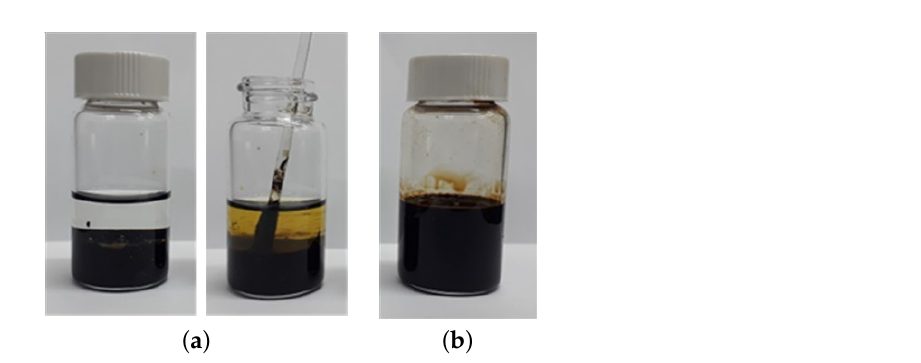
Figure 5. Miscibility of ( a ) mixture of coffee crude oil and decene before/after stirring and ( b ) reaction product of coffee crude oil and decene under supercritical ethanol.